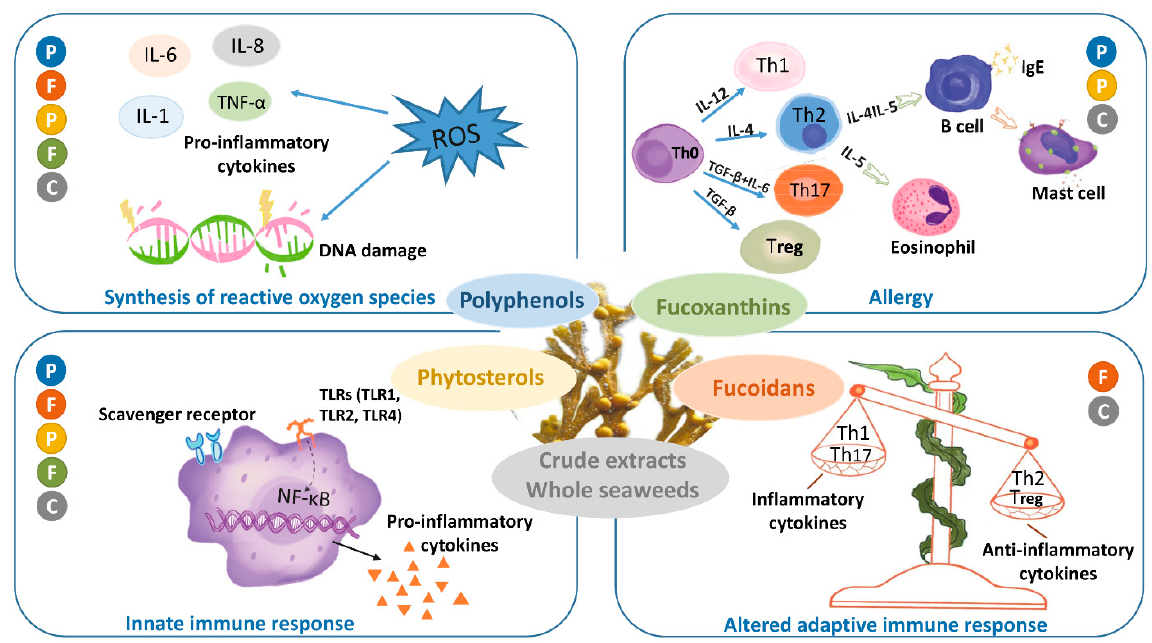
Figure 2. Overview of the general effects of crude brown seaweed or its extracts (C, grey) and of its constituents: polyphenol (P, blue), Fucoxanthin (F, green), Fucoidan (F, brown) and Phytosterols (P, yellow) on the different phases of the inflammatory processes, including allergy. The colored dots showing the crude seaweed or its extract and its constituents in the separate boxes indicate in which phases of the immune response they exert their effects.